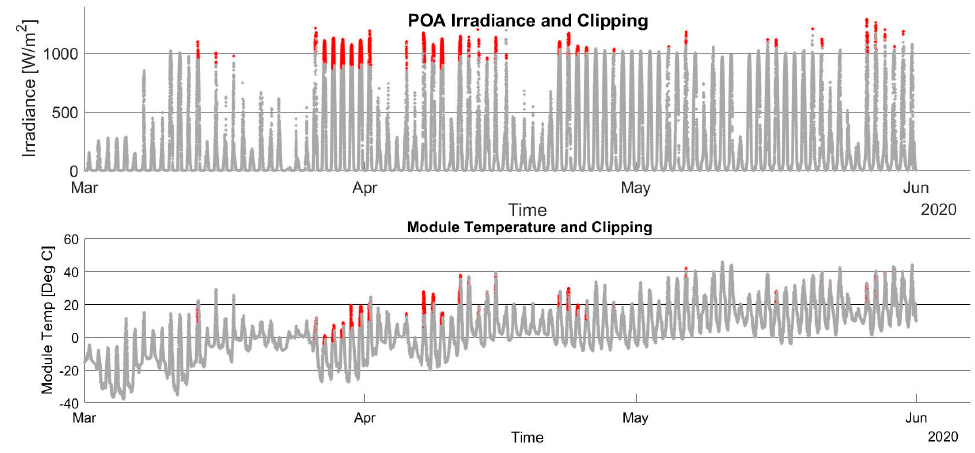
Figure 7. Plane-of-array (POA) irradiance and south-facing bifacial module temperature are shown over time. The data points that correspond to the time of inverter clipping are highlighted in red.